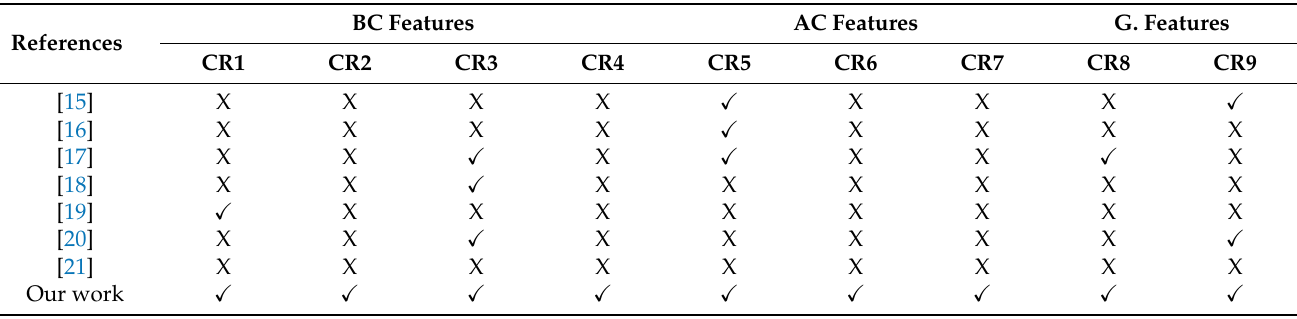
Table 8. Related works